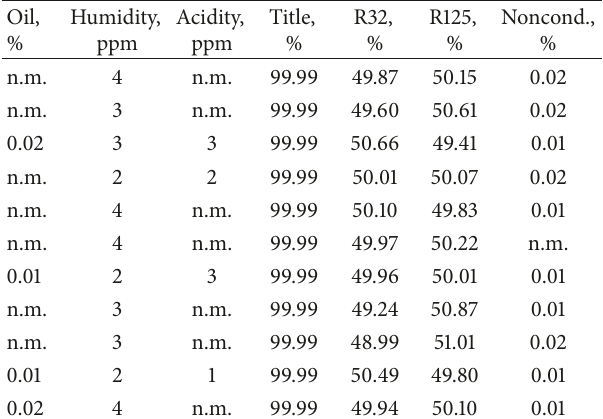
Table 5: R410 analysis after